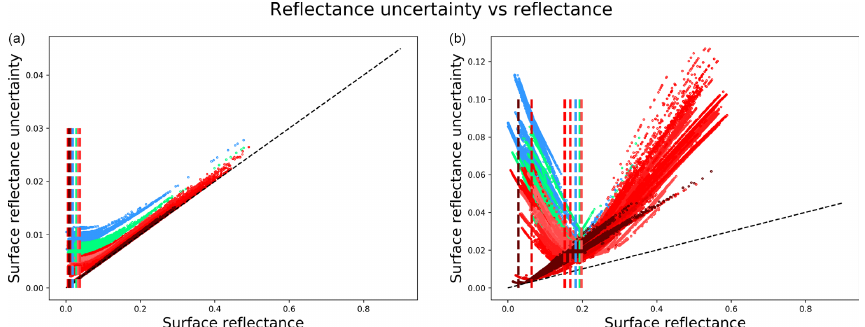
Figure 16. SIAC S2 uncertainty for different bands for low AOT (a) and high AOT (b) . The baseline 5% is noted as a dashed black line, and the minimum of the uncertainty of each band is noted with coloured dashed lines. Colours are used to indicate the bands shown in Fig. 2.